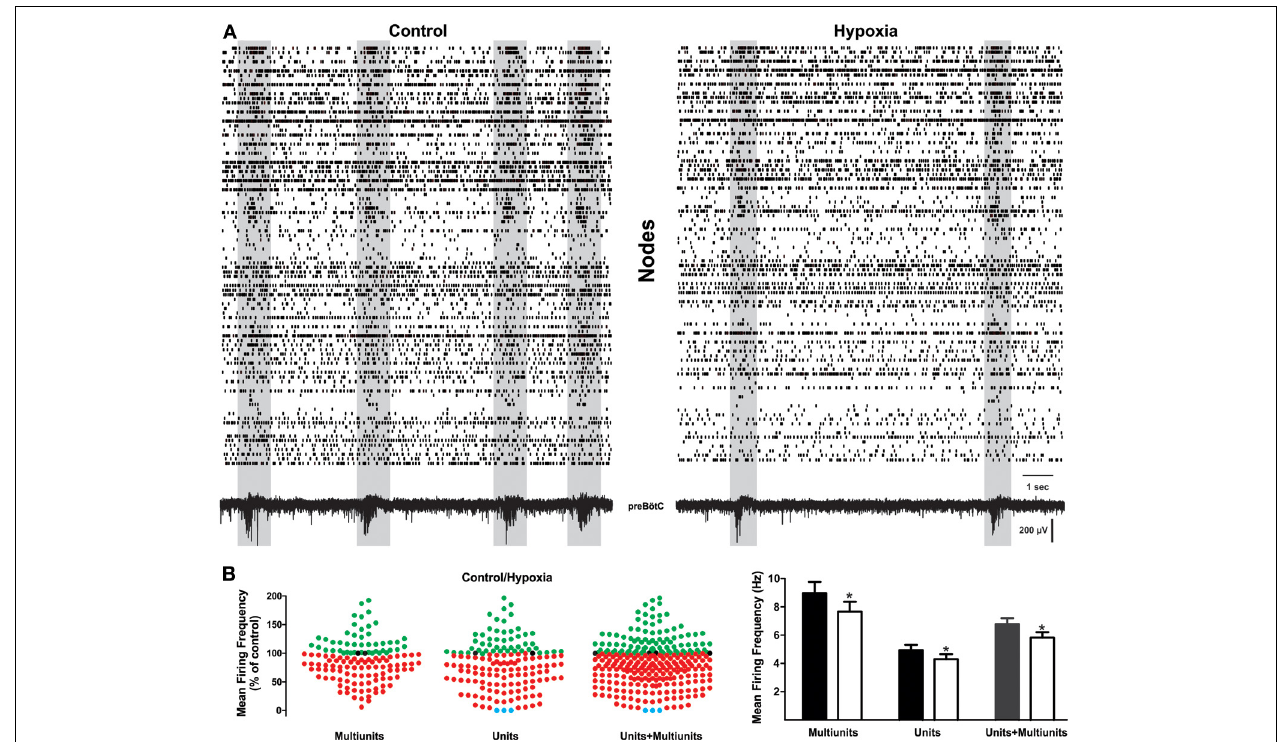
FIGURE 2 | Change in respiratory network activity from normoxic to hypoxic conditions. (A) Raster plots of action potential recordings on different electrodes of the MEA. Lines may represent unitary or multi-unitary recordings, sometimes recorded with the same electrode when these could be distinguished. Each row is the activity obtained from a respiratory element and each vertical line represents a spike. Both fictive-eupnea (control; left) and fictive-gasping (hypoxia; right) are shown. Shadowed frames denote time windows containing an inspiratory event, as depicted by the recording at the bottom. It is readily apparent that these time windows include a significant enhancement of correlated firing among different elements, and they significantly decrease during hypoxia. (B) Quantification of normalized activity change in all respiratory